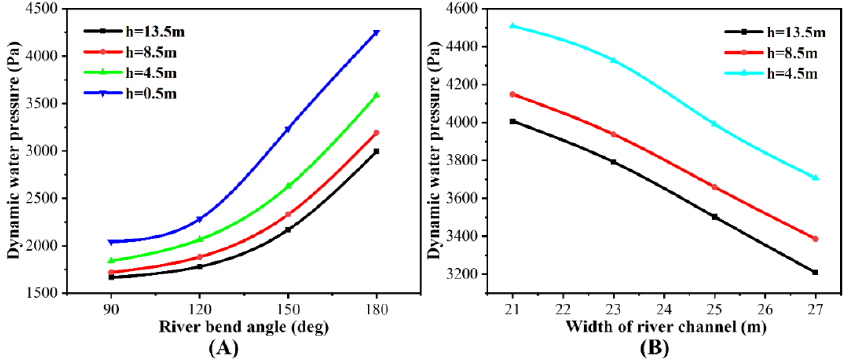
Figure 14. Variation in dynamic pressure with channel width and river bending angle at different elevations; ( A ) width of river channel; ( B ) river bending angle. elevations; ( A ) width of river channel; ( B ) river bending